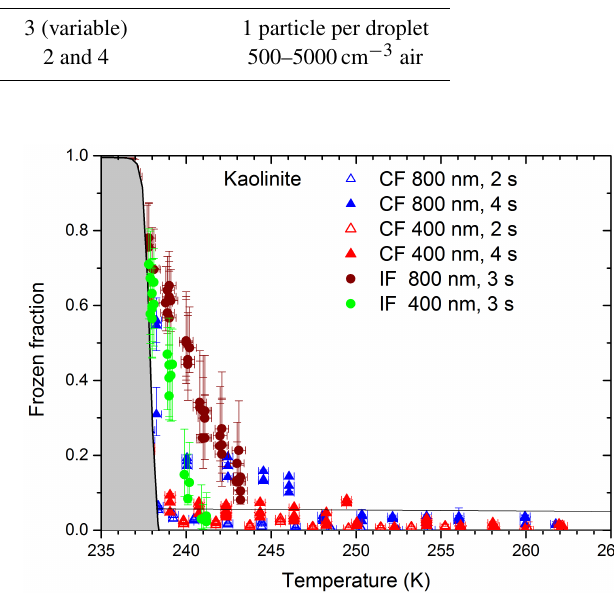
Figure 2. Frozen fraction against chamber temperature for ATD particles of 400nm and 800nm diameter. Contact freezing (CF) for aerosol concentrations of 1000cm − 3 is given by triangles for droplet residence times of 2 and 4s. Immersion freezing (IF from IMCA–ZINC) for 800nm ATD particles and a 3s residence time in ZINC is shown by circles. The gray shaded area shows the ho- mogeneous freezing of droplets determined from blank experiments (without aerosol), and the black horizontal line indicates the lower reliability limit of the measurements determined from the blank sig- nal level observed in experiments without aerosol. Error bars repre- sent the uncertainty in the frozen fraction due to the classification (liquid or ice) uncertainty of the IODE detector (Lüönd et al., 2010).